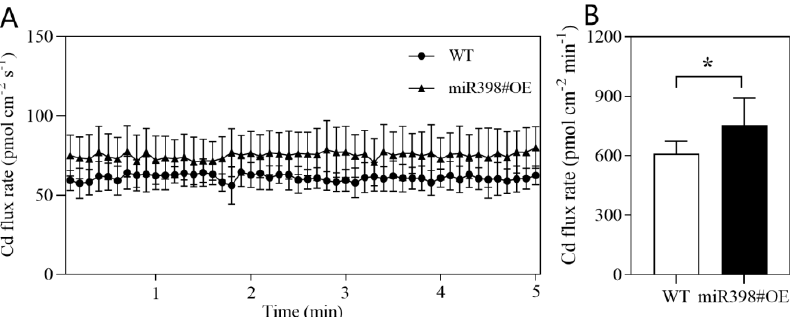
Figure 5. Cadmium flux rate in the root of wild type (WT) and transgenic line overexpressing MIR398 (miR398#OE) under cadmium stress. Stable cadmium flux rate in tomato root in 5 min ( A ) and average cadmium flux rate based on time ( B ). Tomato seedlings (25 d old) of WT and miR398#OE were grown under 100 μM Cd(NO 3 ) 2 for 9 d. The data are the mean values ± or + SD of seven individual replicates. Asterisk indicates significant difference between WT and miR398#OE ( p < 0.05).